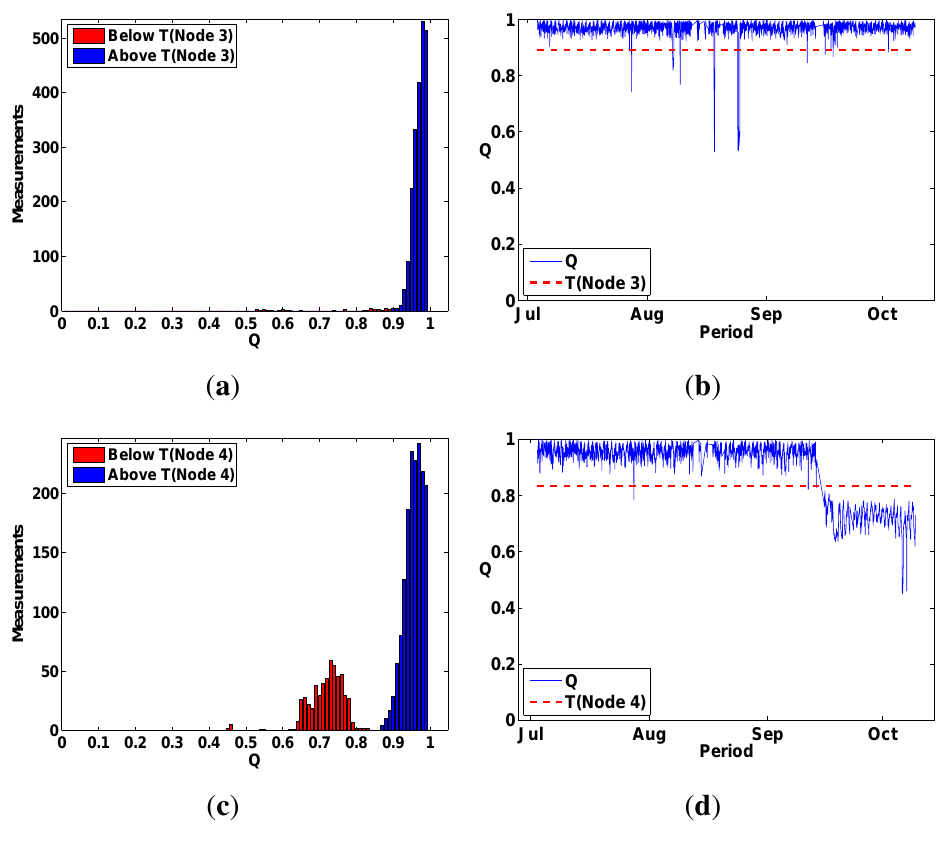
Figure 11. Test Nodes 3 and 4 were placed outdoors for a period of 3 months and measured Q hourly. Q values in Test Node 3 have transient fail events (b) where they fall well below T ( n ) . Test Node 4 drifts below T ( n ) (d) at the end of its operating period suggesting a permanent sensor failure. ( a ) Q distribution Test Node 3 (MK); ( b ) Q values Test Node 3 (MK) 3 months; ( c ) Q distribution Test Node 4 (MK); ( d ) Q values Test Node 4 (MK) 3